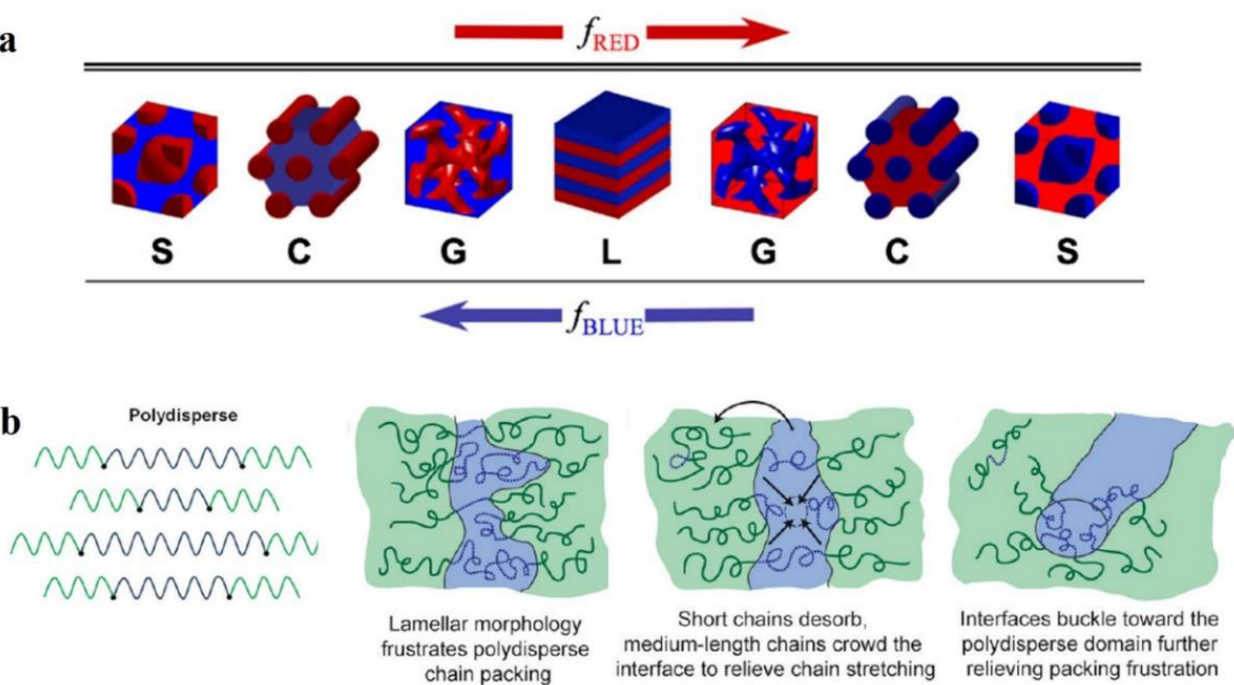
Figure 2. ( a ) Four equilibrium-ordered state transitions in diblock copolymers determined by relative volume fraction f . Spherical (S), cylindrical (C), bicontinuous gyroidal (G), and lamellar (L) [46]. ( b ) Schematic diagram of polydispersed B-blocks in ABA-type triblock copolymers leading to distortion of block microdomain interfaces [54].